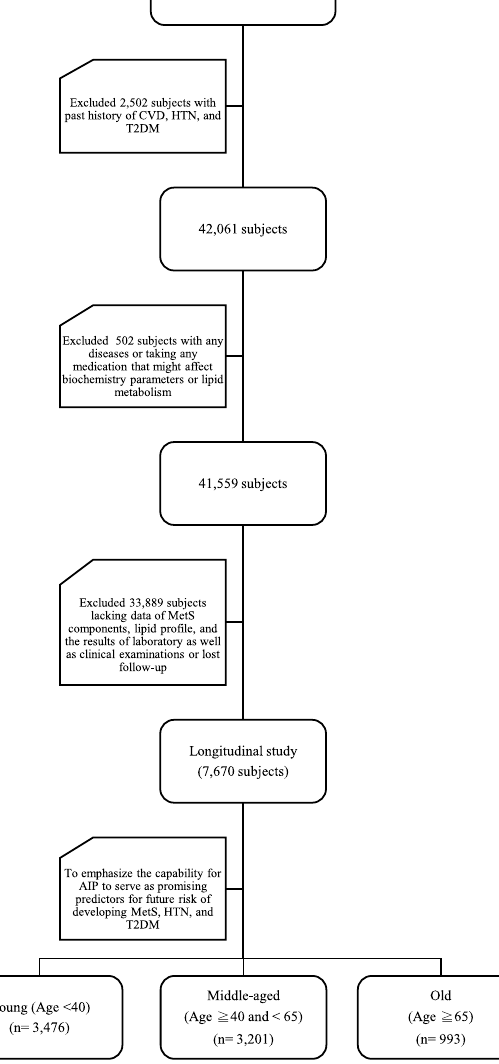
Figure 1. Description of the study design. CVD cardiovascular disease, HTN hypertension, MetS metabolic syndrome, T2DM type 2 diabetes mellitus, AIP atherogenic index of